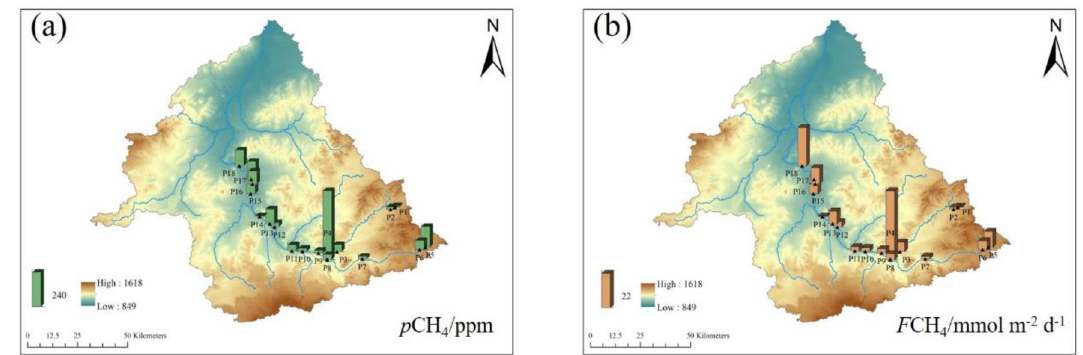
Figure 8. Spatial variation of p CH 4 (a) and F CH 4 (b) in the Xilin River in 2018 (generate by Arcgis 10).